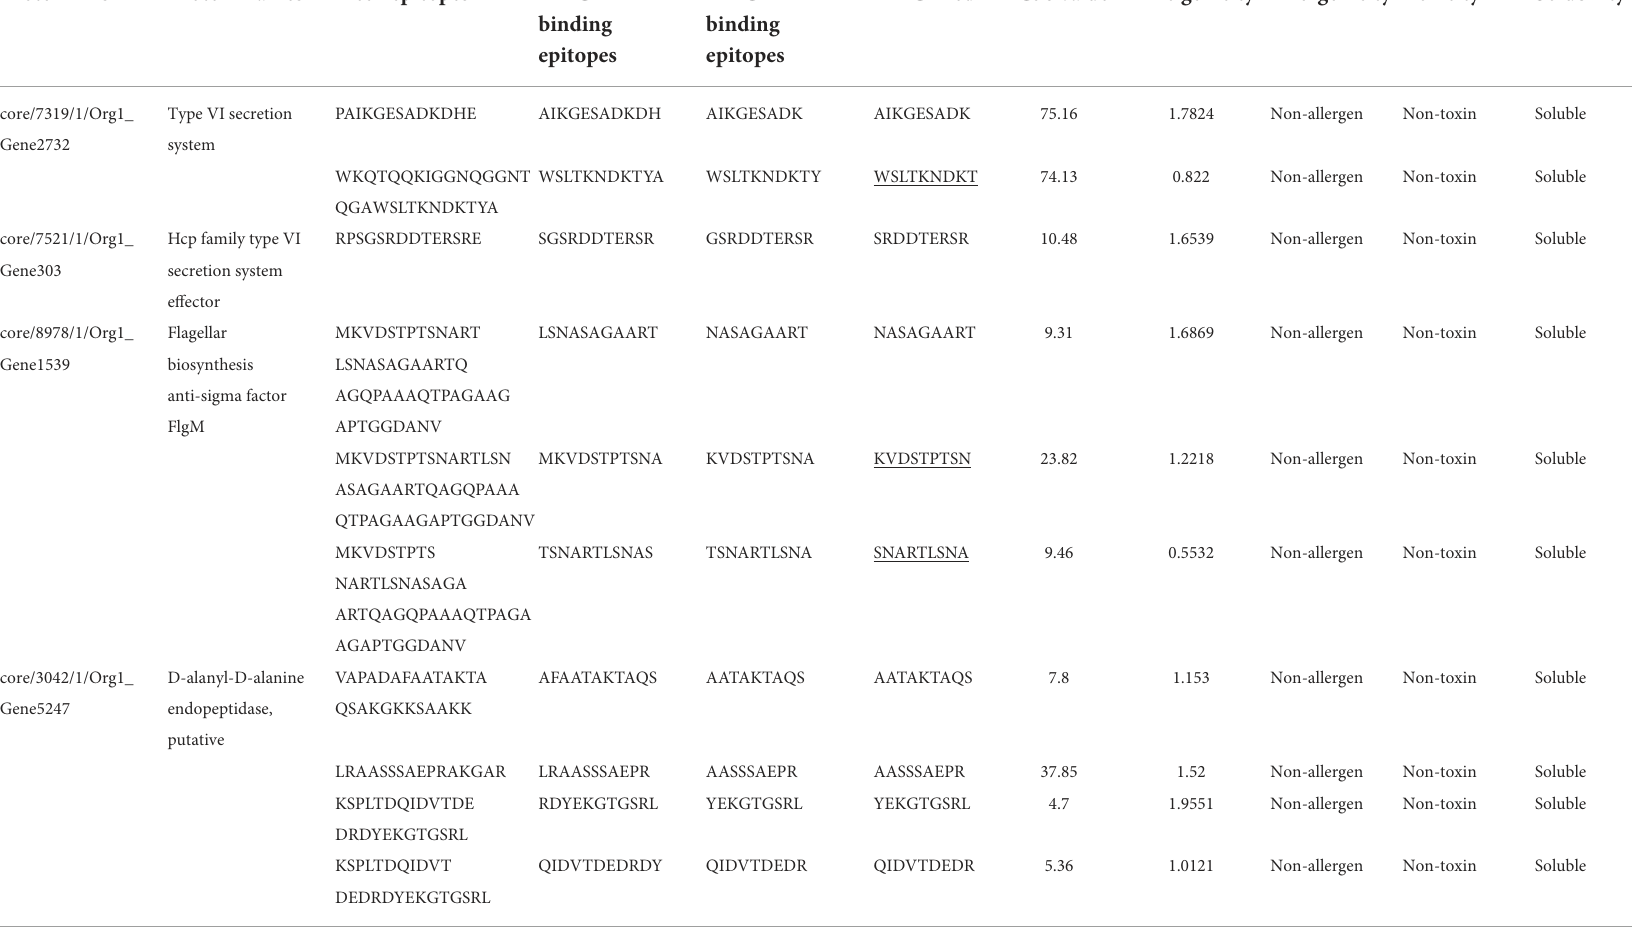
TABLE 2 Predicted B cell derived T cell epitopes with various